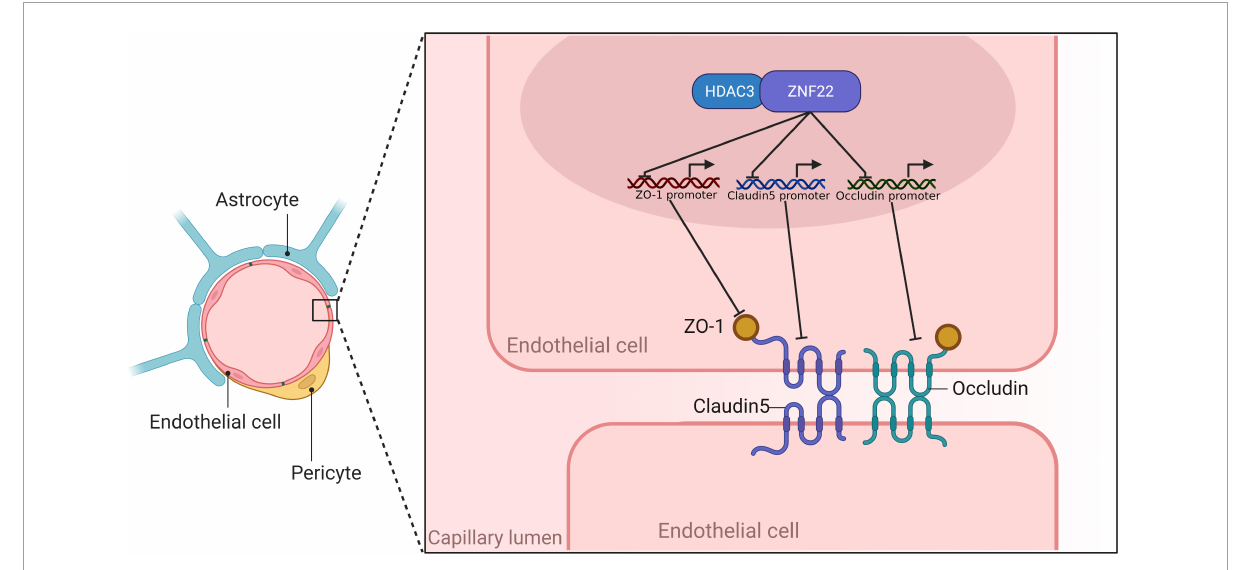
FIGURE6 Schematic diagram of ZNF22 and HDAC3 to regulate BTB